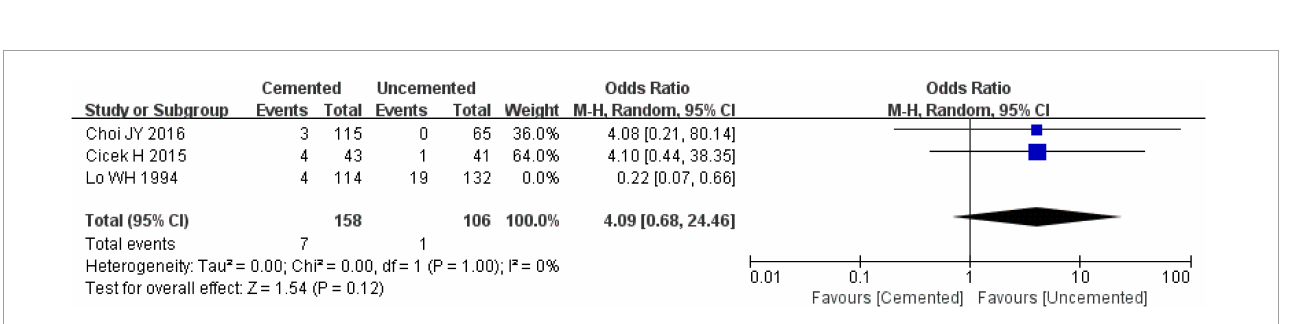
FIGURE15 Forest plot for comparison of subsidence of prosthesis (>5 mm) between cemented bipolar hemiarthroplasty (CBH) group and uncemented bipolar hemiarthroplasty (UCBH) group.